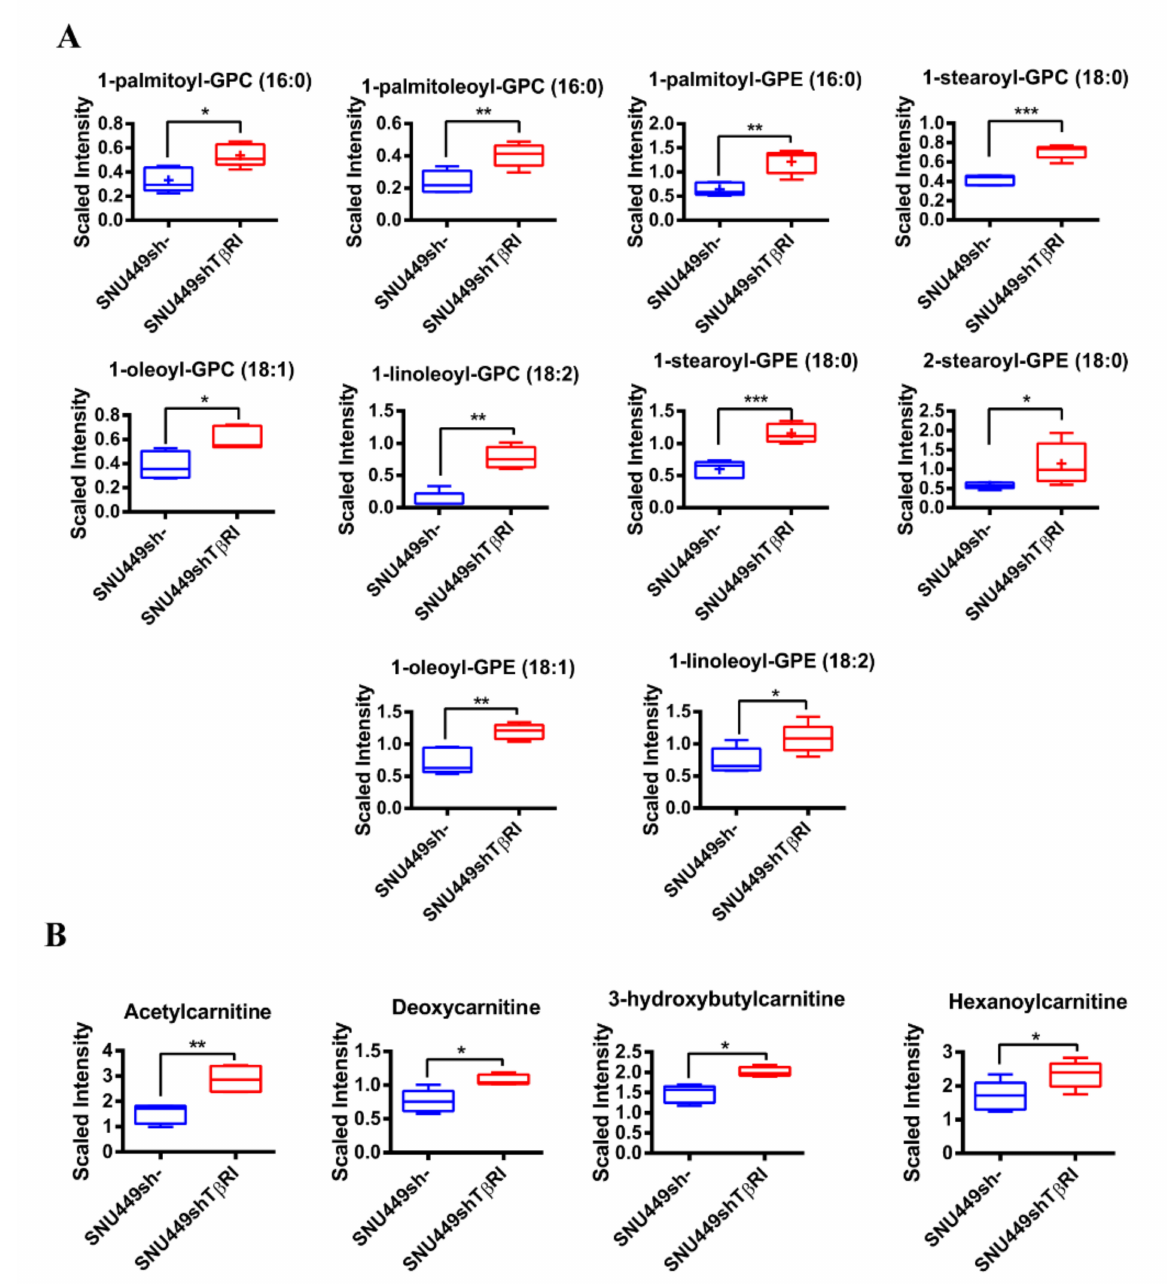
Figure 4. Lipidomic analysis in SNU449shT β RI cells. Levels of lysolipids ( A ) and carnitine-related metabolites ( B ) are depicted by a box plot with whiskers (min to max). Welch’s two-sample t -test was used to identify biochemicals that differed significantly between experimental groups ( n = 5 for each group). * p < 0.05, ** p < 0.01, *** p <